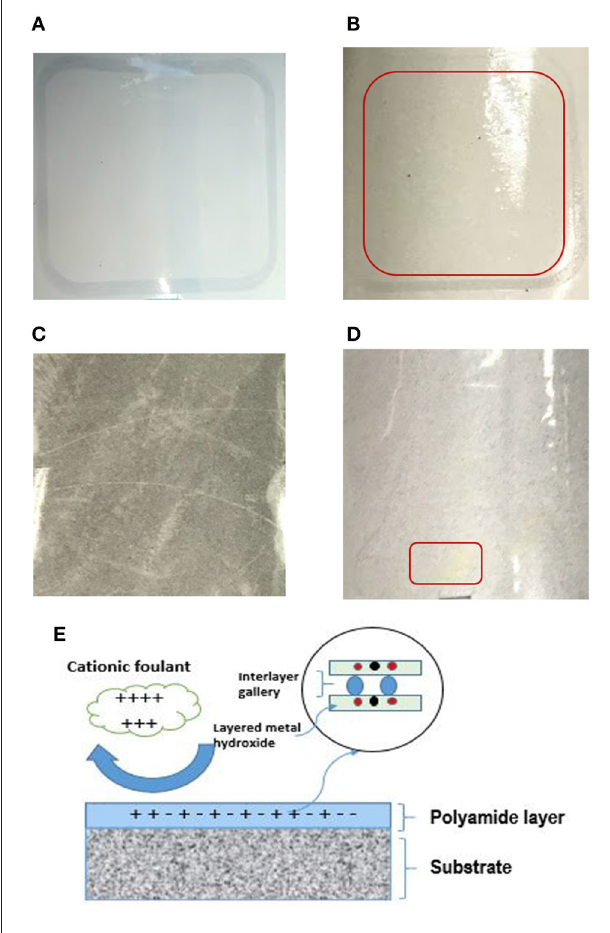
FIGURE 12 | Digital image of membrane before (A) TFC and (C) TFN 2 and after filtration of BSA (B) TFC and (D) TFN 2 (E) proposed mechanism of anti-fouling for LDH-filled TFN